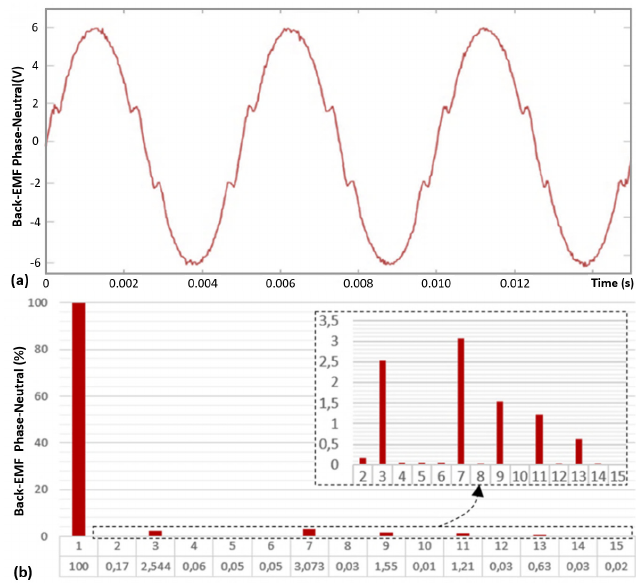
Figure 3. Control implementation on the processors.